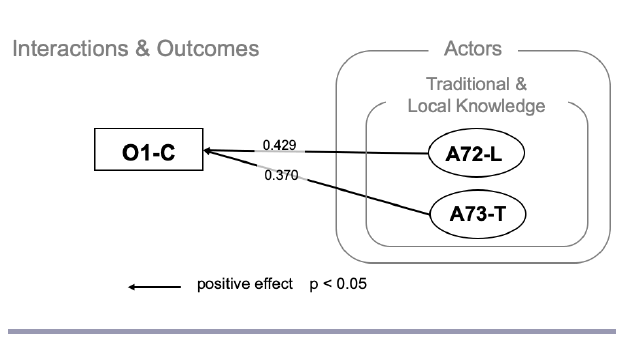
Fig. 4 . Results of the multiple regression analysis for variables related to the participation of diverse actors as response variables. Only the significant and marginally significant relationships are shown here. Full results are shown in Appendix 4. A12-C: Number of local biodiversity strategies and action plan